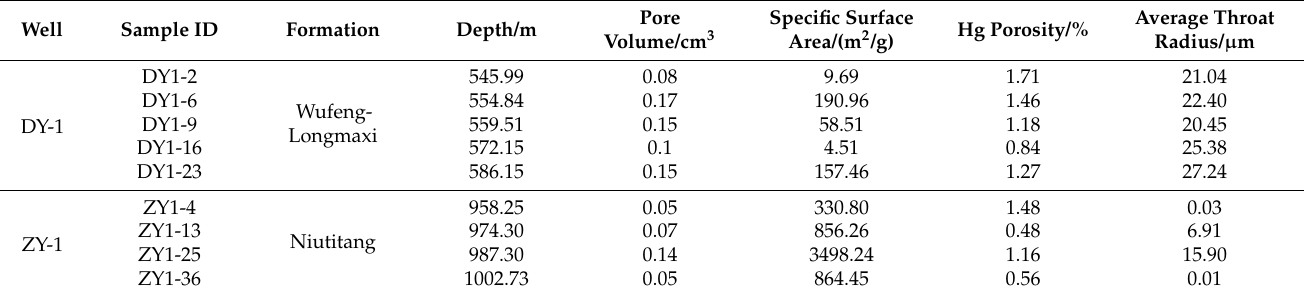
Table 5. Pore structure parameters of shale in the Wufeng-Longmaxi and Niutitang Formations in northern Guizhou Province based on the high-pressure mercury intrusion method.